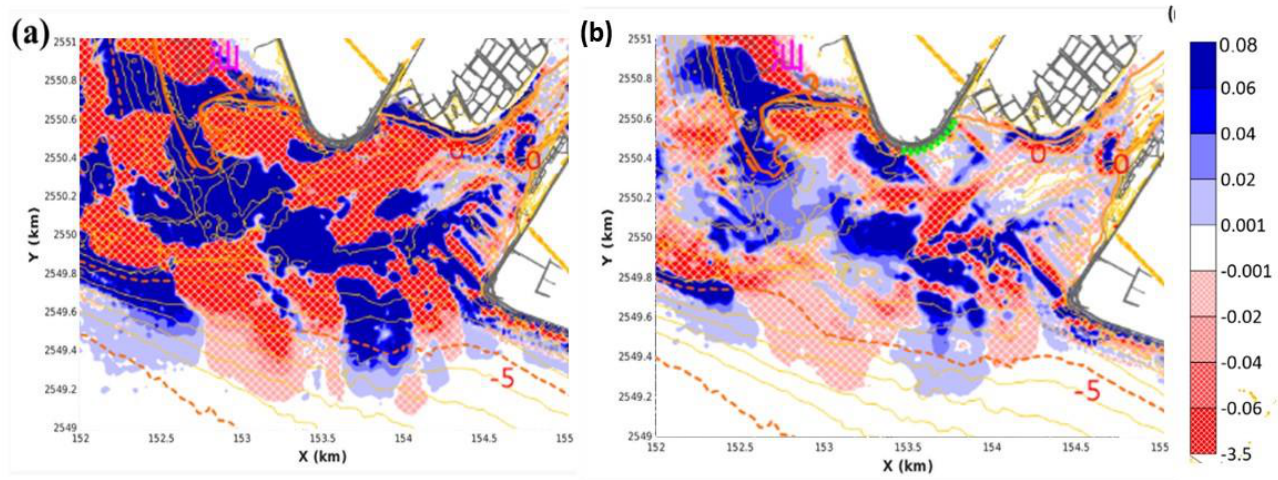
Figure 12. The modeled morphological change ( a ) before and ( b ) after the construction of groins.